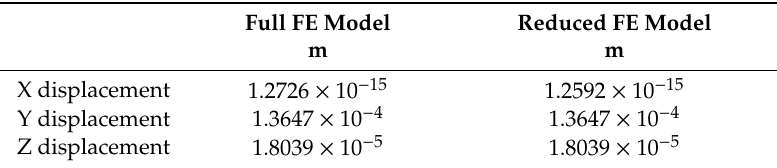
Table 1. Results of the comparison.